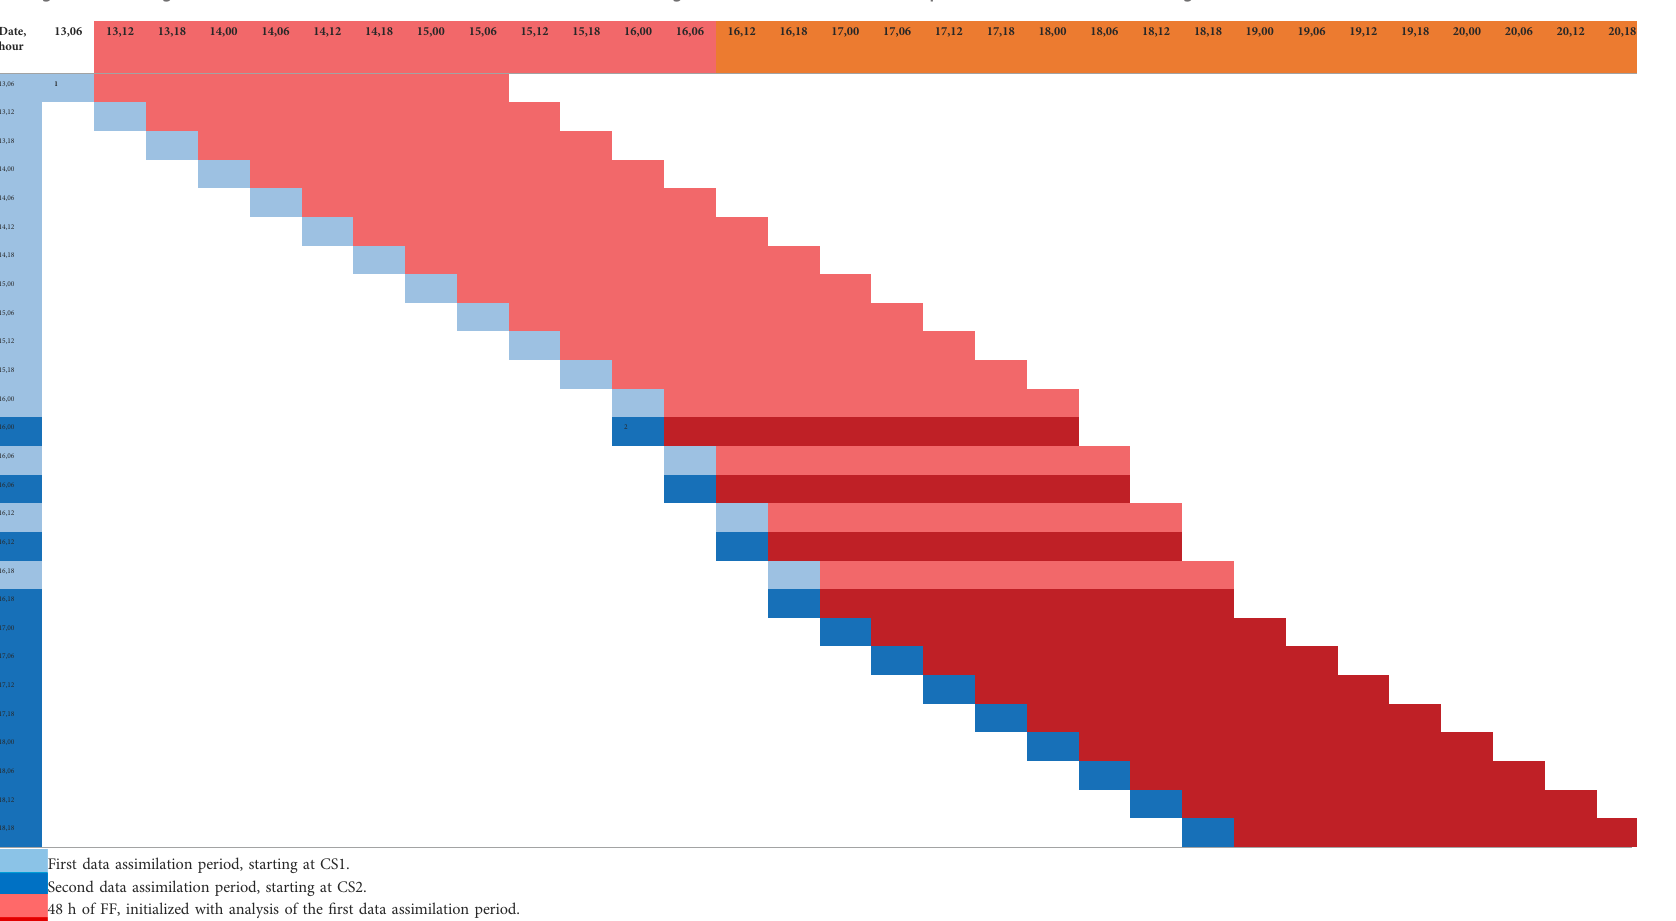
TABLE 1 Summary of WRF-Chem-RTFDDA runs. Pairs of numbers in fi rst column and row indicate dates in March 2016 (from 13 to 18) and UTC time in 6-h intervals (from 00 to 18). Beginning of fi rst continuousdataassimilationperiod(P1)isindicatedasoneonthelight-bluecellcorrespondingto06UTC13March2016( fi rstcoldstart,CS1).Light-bluecellsindicate6-hintervalsofcontinuousdata assimilation following CS1 during P1. Light-red cells indicate 48-h free forecast (FF) initialized with analysis obtained at the end of each 6-h interval of continuous data assimilation during P1. Similar numbering andcolor rules butusing dark-red and dark-blueareused for the second continuous dataassimilation period,P2,starting on00UTC16March2016 (second cold start,CS2). Colors inthe fi rst row indicate periods of time for which FF were initialized with analysis obtained during P1 (light-red), FF initialized with analysis obtained during P2 (dark-red) and FF initialized with analysis obtained during P1 and during P2 (brown). Bold values in the fi rst column refer to FF during the second data assimilation period associated and following CS2.